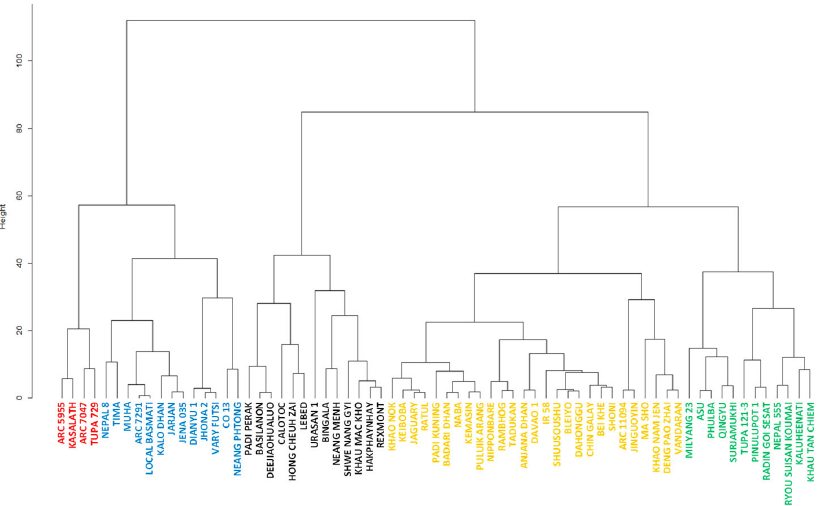
Figure 5. Cluster dendrogram for the classification of 69 accessions in World Rice Core Collection based on pre ‐ and post ‐ attachment resistance.